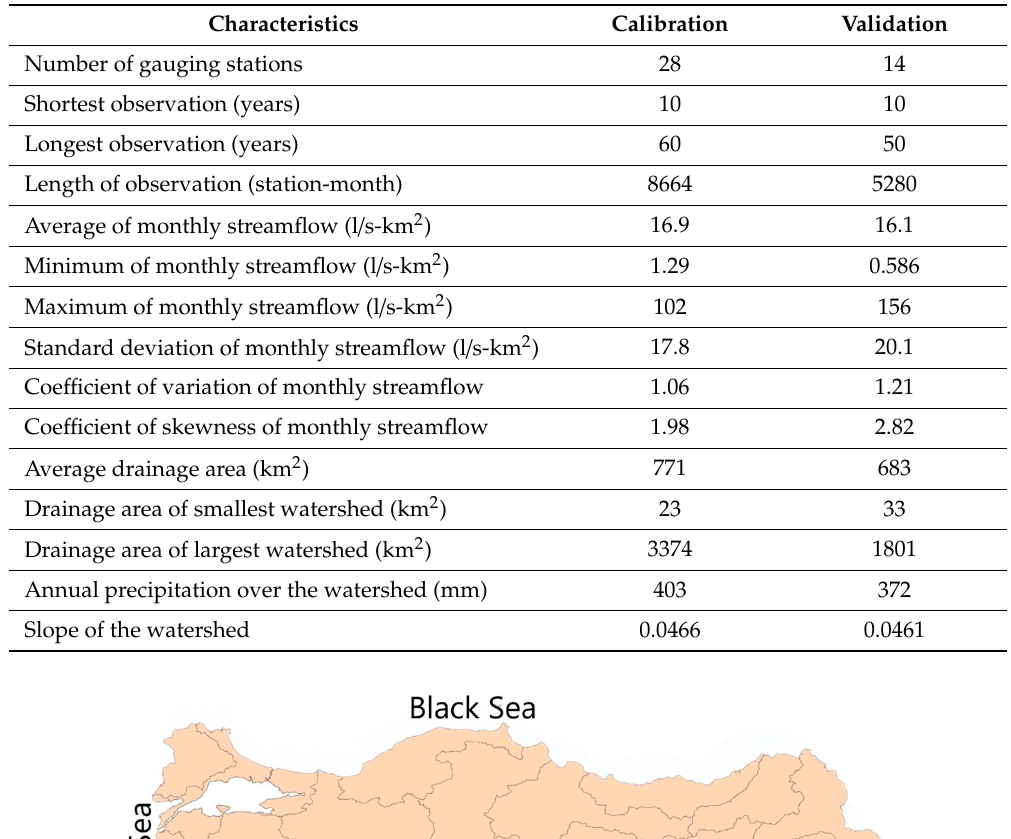
Table 4. Characteristics of streamflow data used in the study.